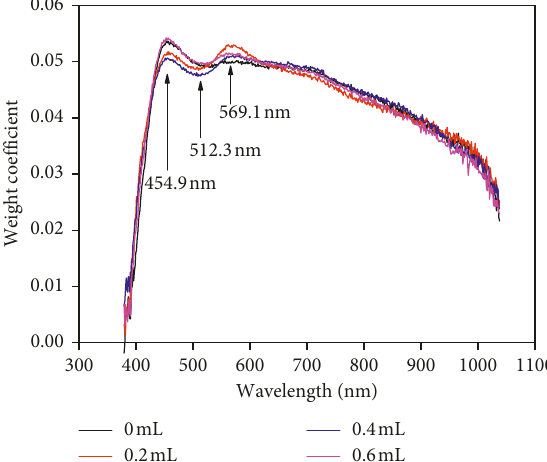
Figure 4: Weighting coefficients of the samples with different water amounts